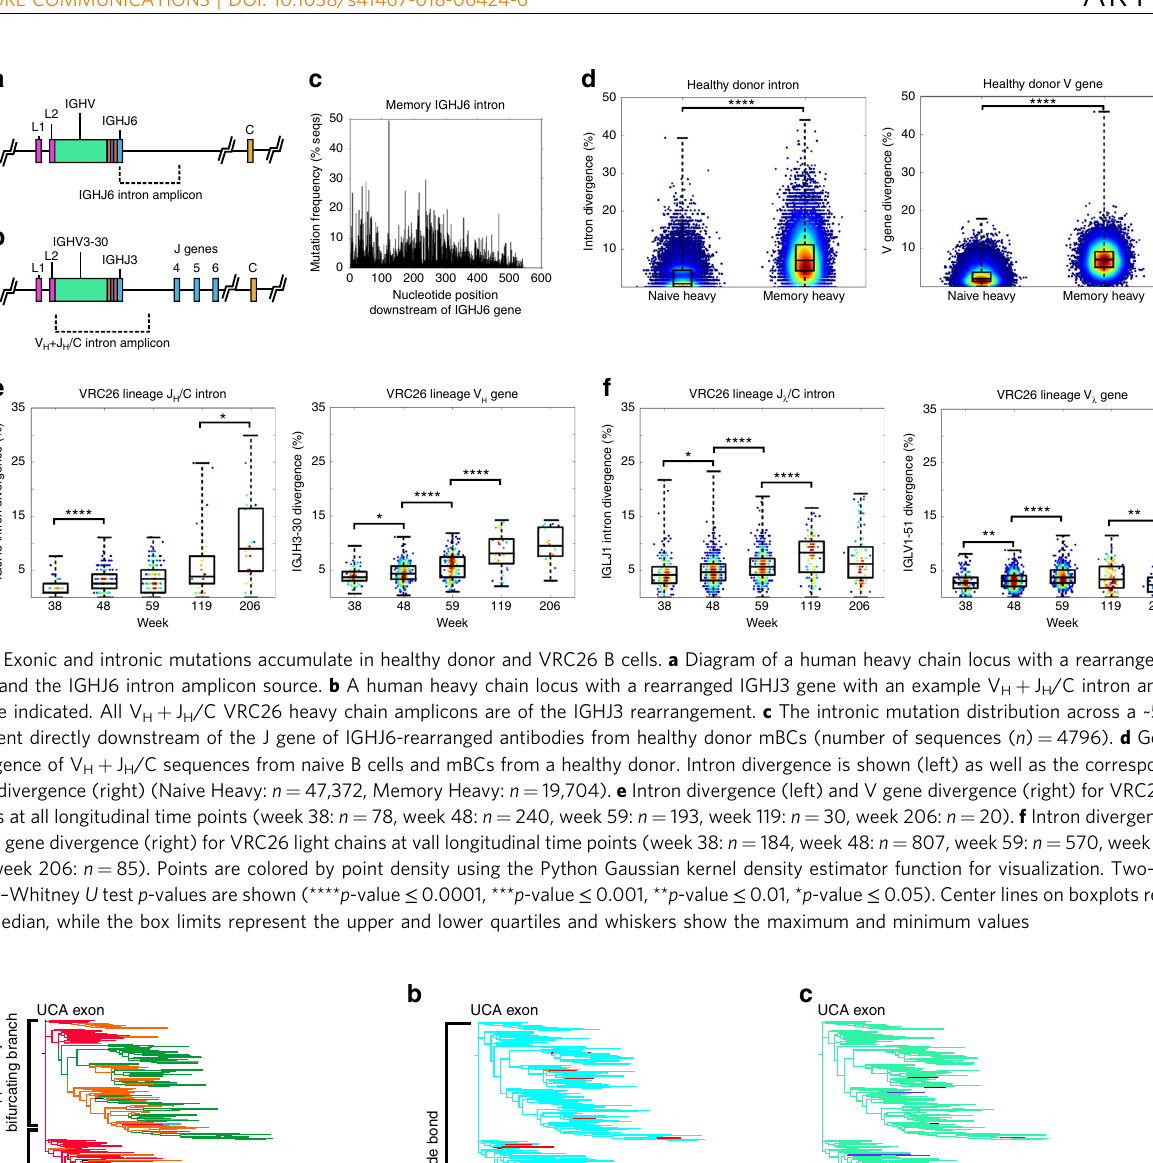
NATURE COMMUNICATIONS| (2018) 9:4136 |DOI: